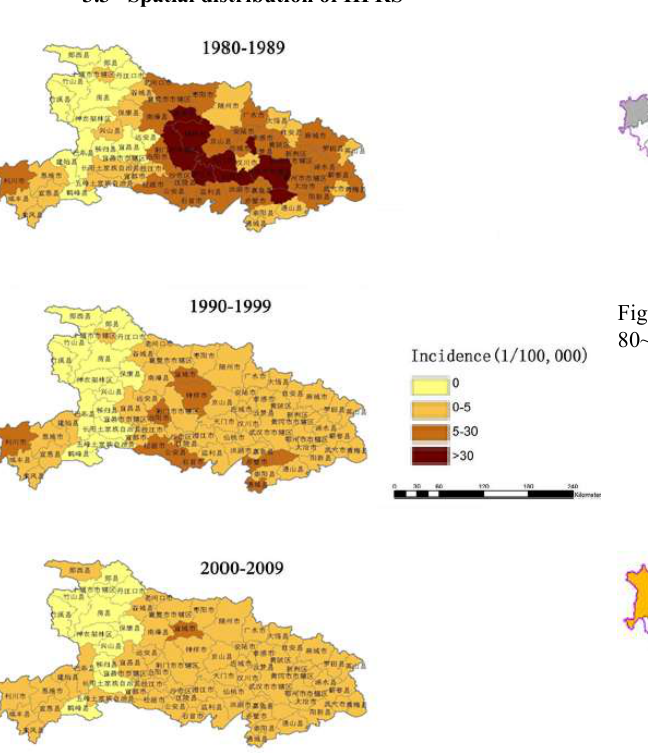
Figure 4 Hubei HFRS Spatial Distribution every ten years from 1980 through 2009.